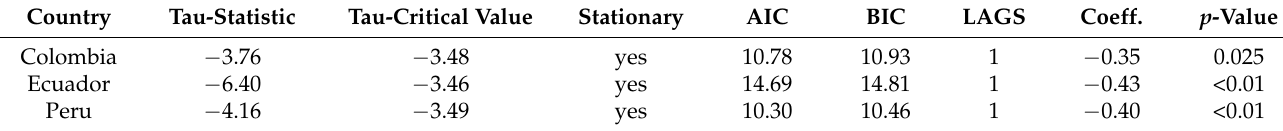
Table 1. ADF test for non-stationary time series Average EMBI Spread.